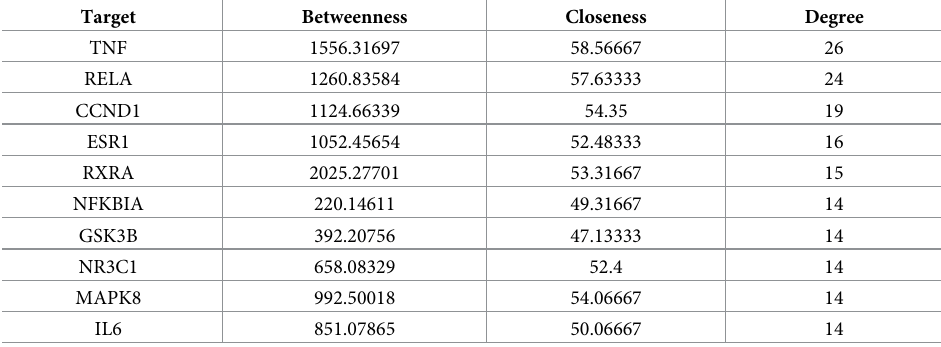
Table 2. The PPI network characteristics of the top 10 hub